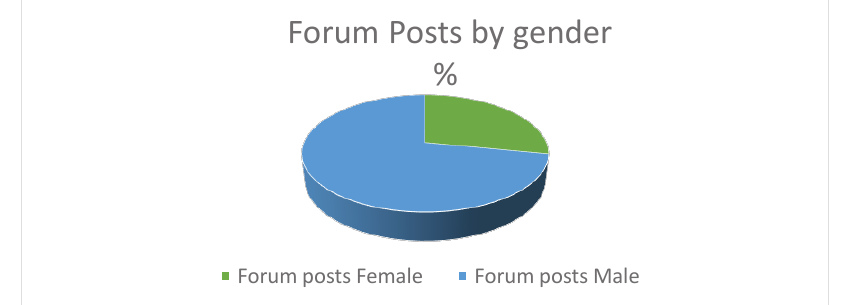
Fig. 6: Forum Posts by